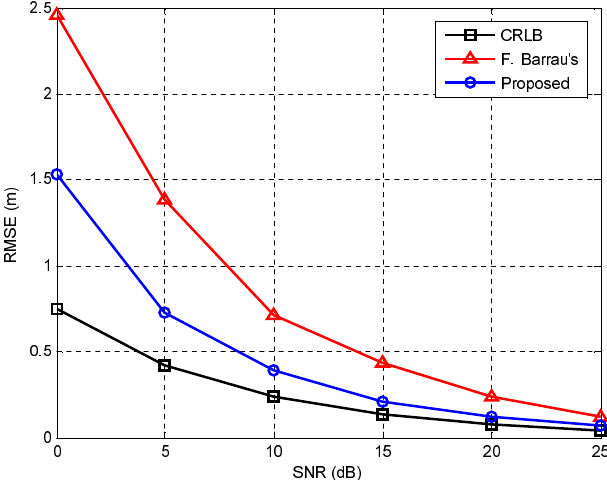
Figure 8. Performance comparison of proposed algorithm and F. Barrau’s algorithm [18]. CRLB: Cramer-Rao lower bound, presented for